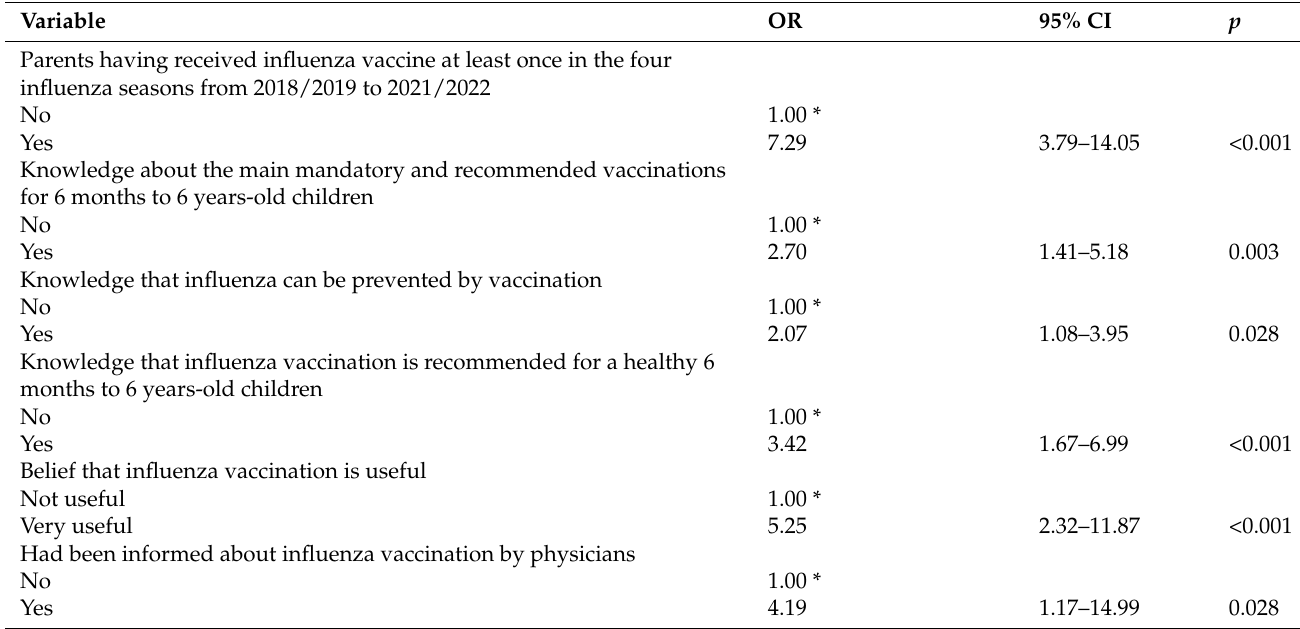
Table 2. Multivariate logistic regression analyses to characterize factors associated with having vaccinated at least once their children in the four influenza seasons from 2018/2019 to